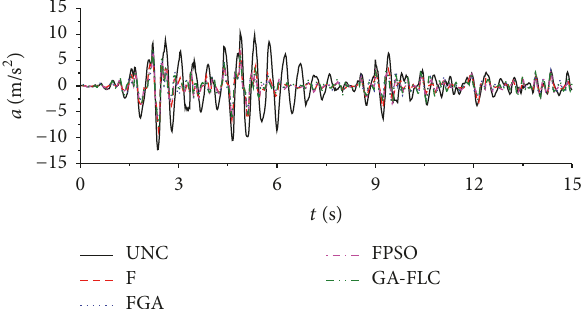
Figure 18: Top-layer acceleration response curve under the action of the El Centro wave.